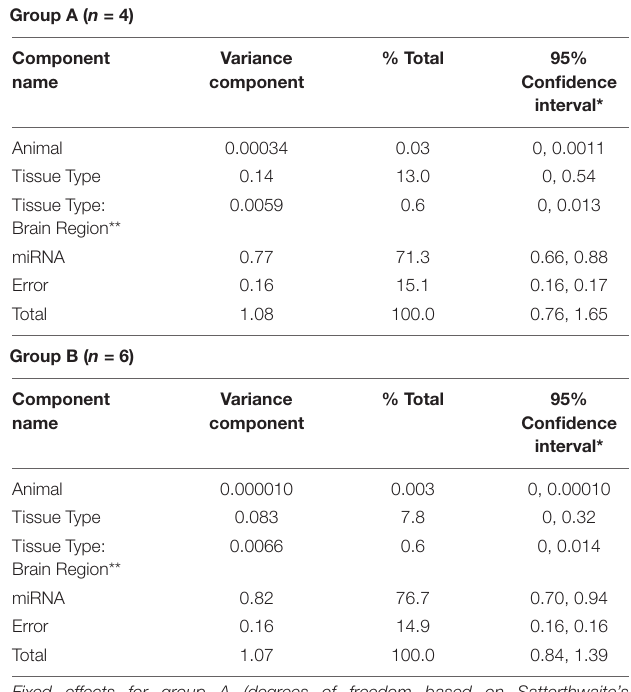
TABLE 4 | Results of variance components analysis of miRNA expression